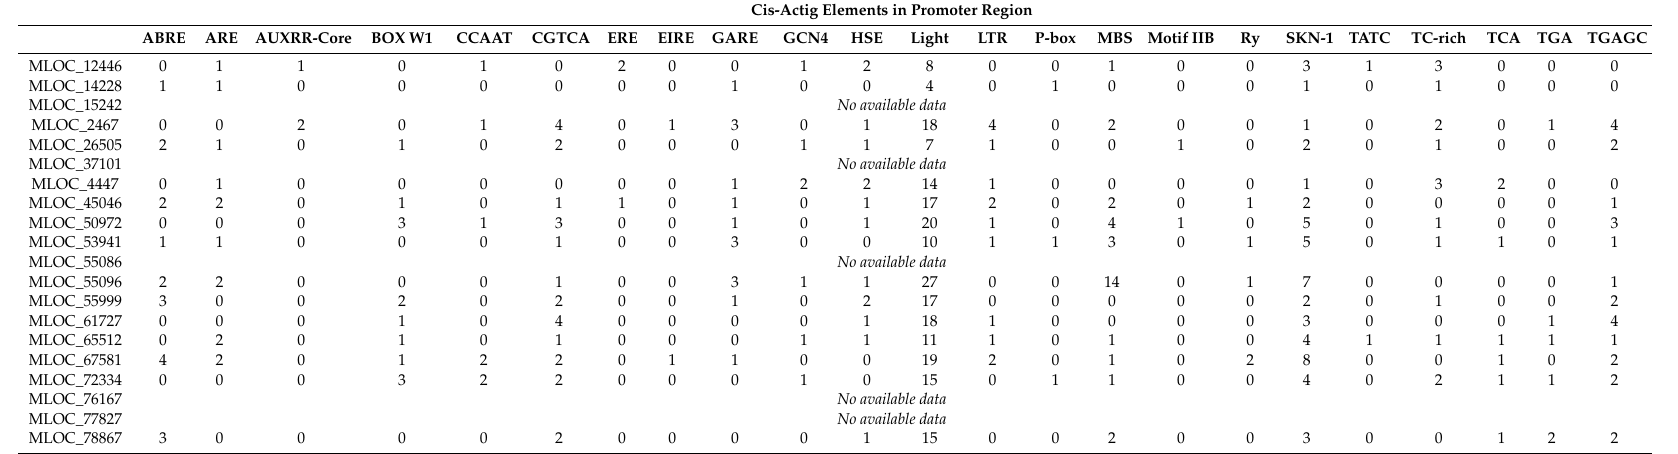
Table 3. The regulatory cis-acting elements of the barley HSP70s promoters (1500 pb upstream region). The legend for motifs: ABRE and motif IIB(abscisic acid response); ARE (anaerobic induction); AUXRR-COR (auxin response); GCTCA & TGAGC (Me-Jasmonate—response); Box W1 & EIRE (Elicitor responsive elements); ERE (ethylene-responsive element); GARE & P-BOX (gibberellin-responsive element); GCN4 & Skn-1_motif (regulatory element required for endosperm expression); HSE (heat stress response); MBS (MYB binding site involved in drought response); LTR (in low-temperature response); p-BOX (gibberellin-responsive element); Ry elements (seed-specific regulation); TATC (gibberellin-response); TC-rich repeats (defense and stress response); TCA (salicylic acid response); TGA (auxin- response). Cis-Actig Elements in Promoter